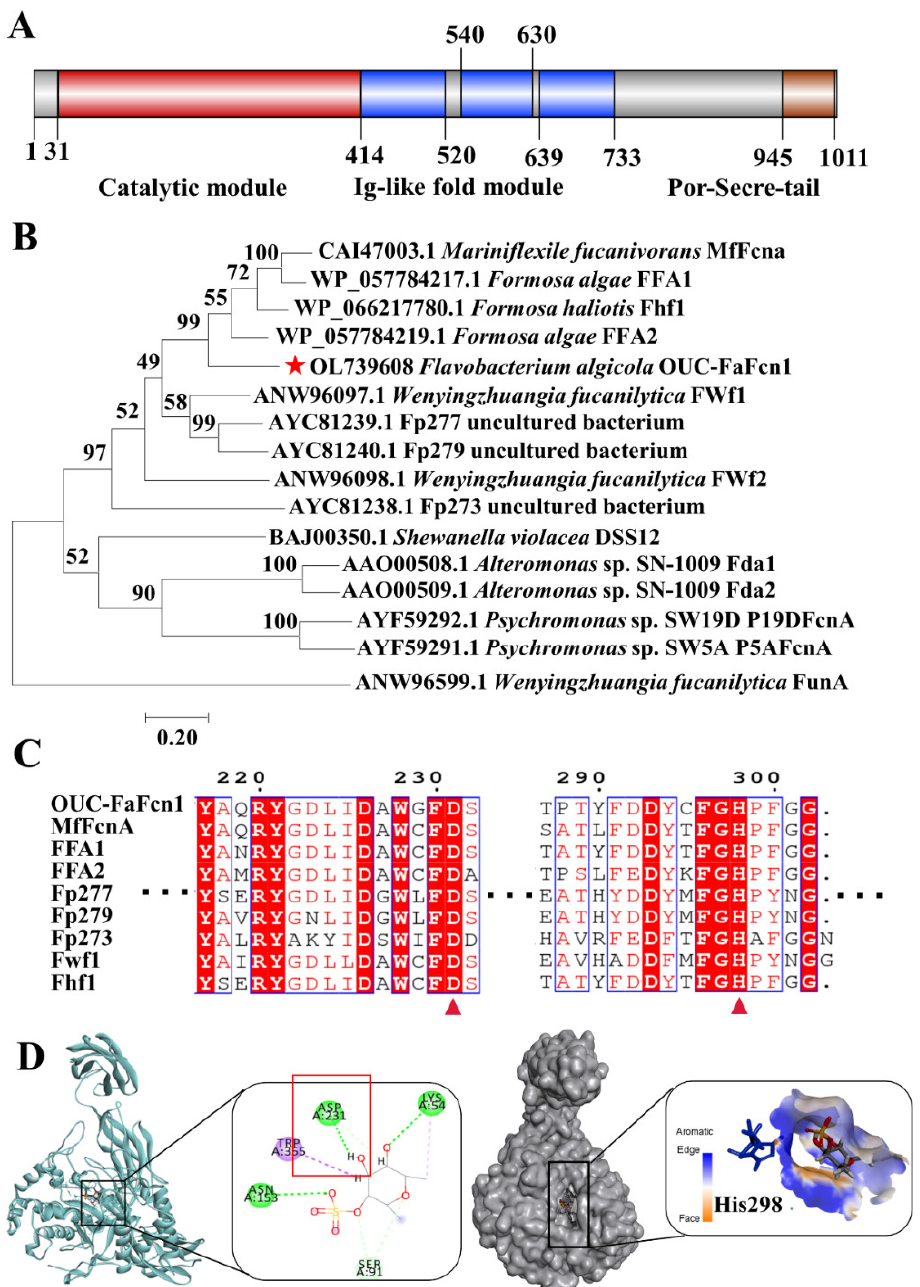
Figure 1. Mining and sequence analysis of α - L -fucoidanase OUC-FaFcn1. ( A ) Protein domain analysis of OUC-FaFcn1. ( B ) Phylogenetic analysis of OUC-FaFcn1 with other α - L -fucoidanases that were recorded in GH107 family. The neighbor-joining tree was obtained using MEGA 7.0. The red star indicates OUC-FaFcn1 of this study. ( C ) Protein sequence alignment of OUC-FaFcn1 with FcnA from M. fucanivornans (CAI47003.1), FFA1 and FAA2 from F. algae (WP057784217.1, WP 057784219.1), Fhf1 from F. haliotis (WP 066217780.1), FWf1 from W. fucanilytica CZ1127 T (ANW96097.1), Fp273, Fp277, and Fp279 from uncultured bacterium (AYC81238.1, AYC81239.1, AYC81240.1). The two catalytic residues including Asp231 and His298 were marked by a red triangle. ( D ) Homology modeling structure of OUC-FaFcn1. The two catalytic residues including Asp231 and His298 which are located in the catalytic pocket were marked.